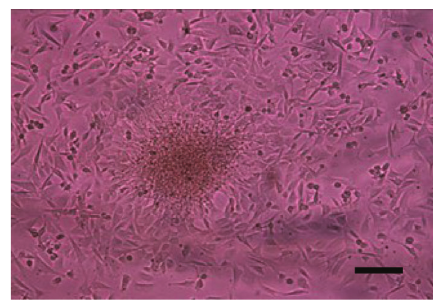
Figure 1. Colony-like growth of second generation of bone marrow progenitor cells. Bar = 100 m m.